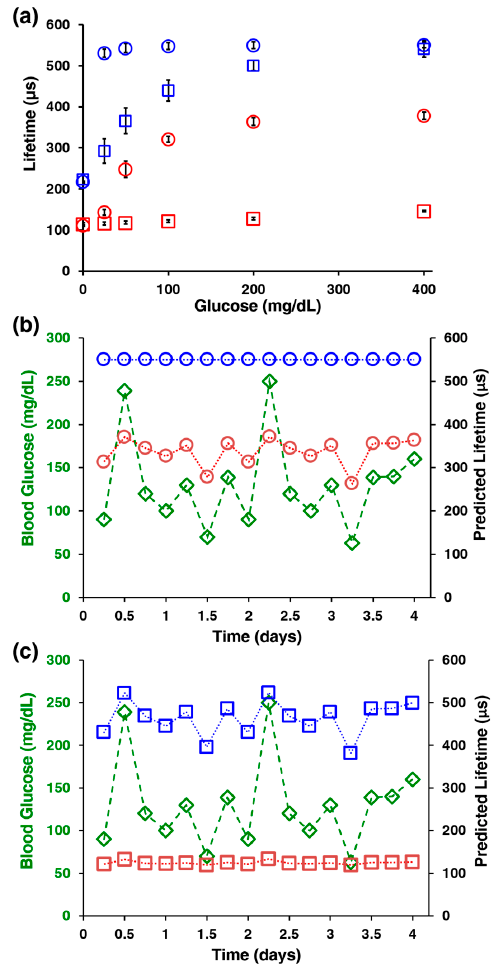
Figure 3. Calibration and performance stability of AnA hydrogels. ( a ) AnA hydrogel response to varying glucose concentration (0–400 mg/dL) for non-crosslinked (blue ○ or red ○ , ambient and low oxygen, respectively) and crosslinked (blue □ or red □ , ambient and low oxygen, respectively) microparticles. Error bars represent 95% confidence intervals for three separate samples of the same formulation; ( b , c ) Simulated blood glucose levels (green ◊ , left axis) collected over time and the predicted response of each AnA hydrogel (blue and red, right axis). The predicted values indicate estimated responses from the calibration of materials containing either non-crosslinked (blue ○ or red ○ , ambient and low oxygen, respectively) or crosslinked (blue □ or red □ , ambient and low oxygen, respectively) microparticles.